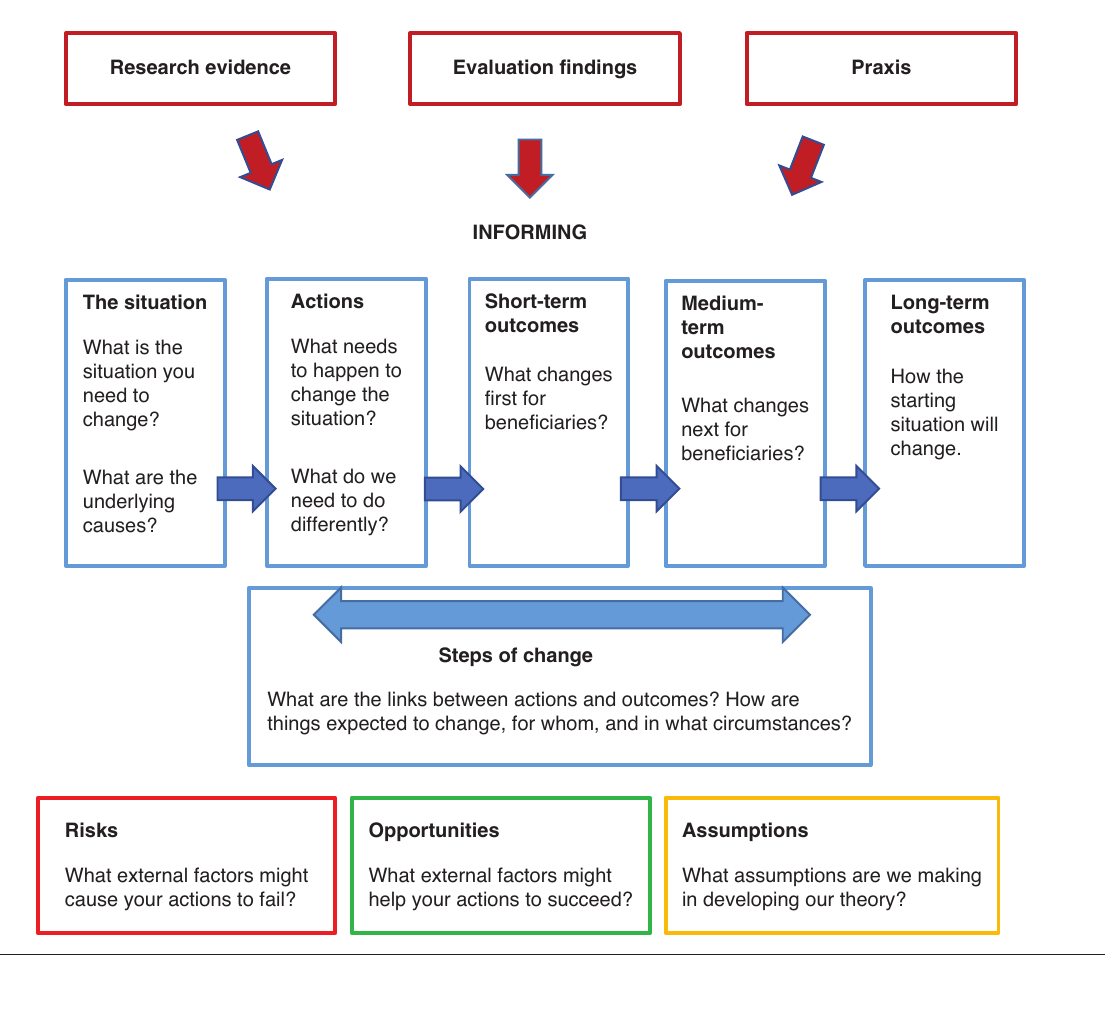
Figure 1. The framework for a synergic theory of change (Source: Author,